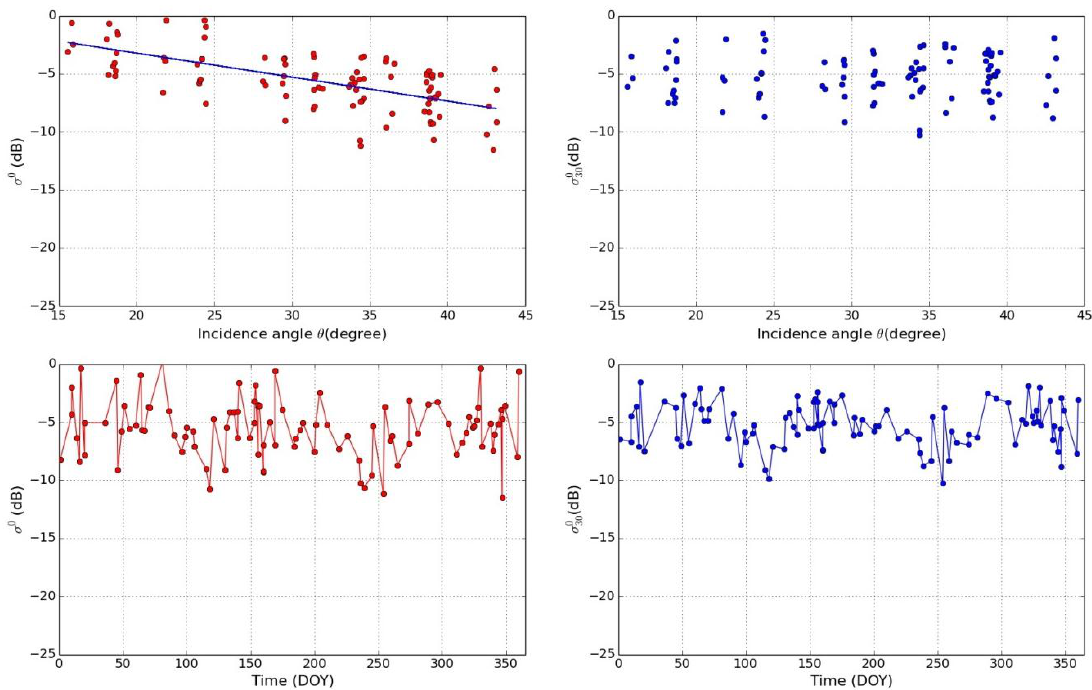
Figure 6. Time series of backscatter over rice-cropped area (backscatter vs. incidence angle, original backscatter and normalized backscatter).